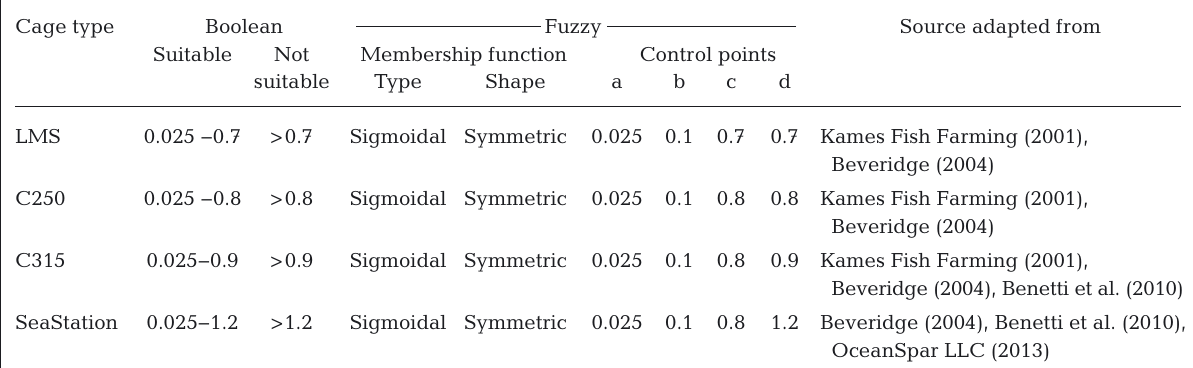
Table 2. Current velocity (m s −1 ) reclassified in terms of suitability ranking for each cage